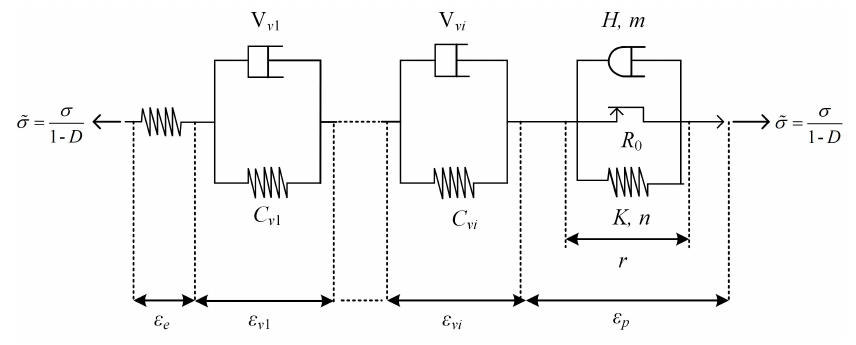
Figure 27. A schematic representation of the rheological